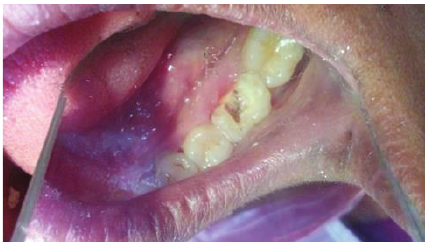
Figure 41: Photograph showing the fracture of the cusp 36 at the end of the 4-month